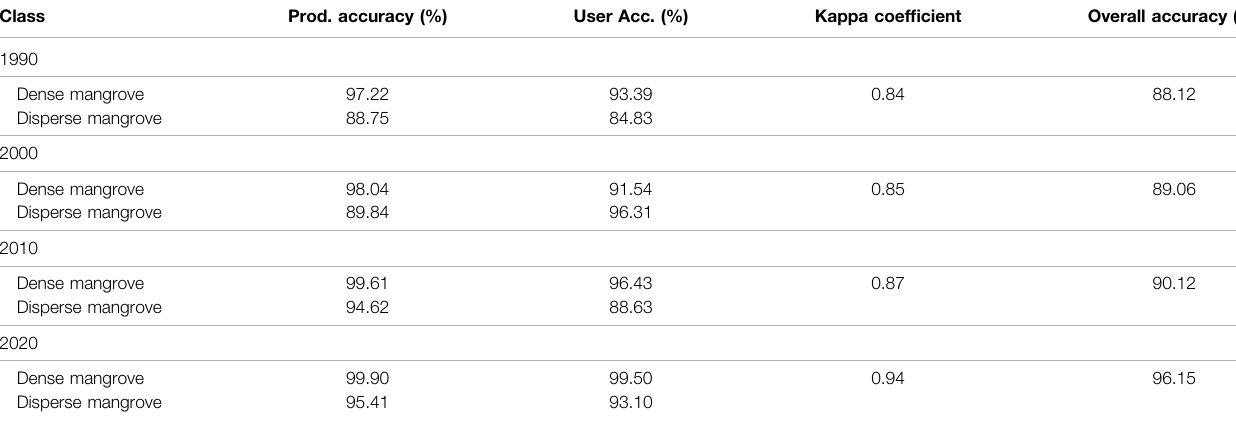
TABLE 1 | Confusion matrices of the resulting mangrove maps (1990 –